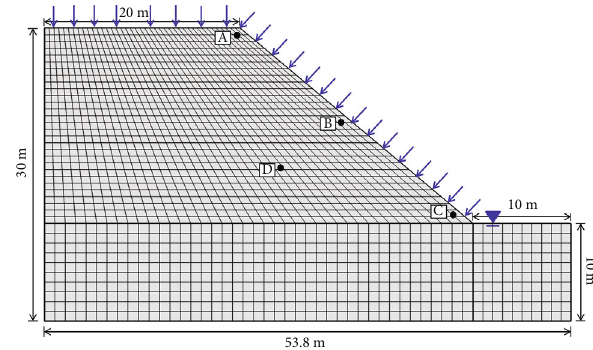
Figure 2: Physics generalization model of